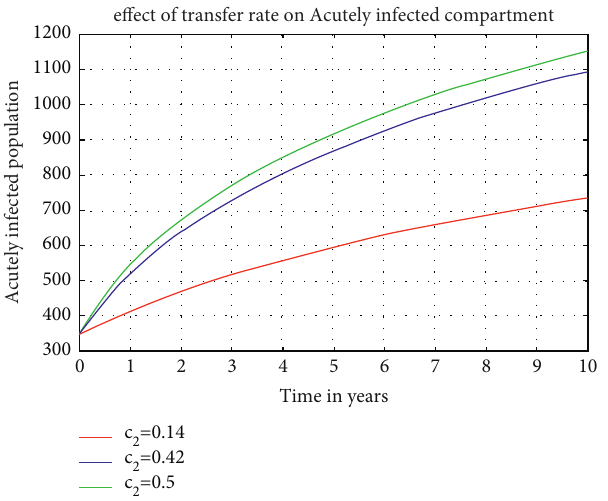
Figure 13: Effect of treatment rate on chronically infected